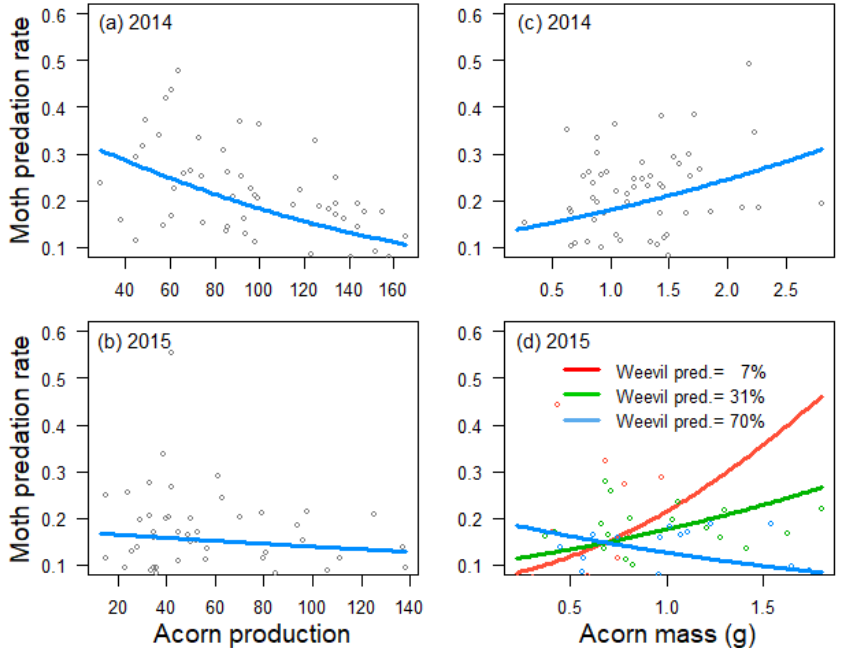
Figure 2. Relationship between tree crop size and moth predation rate in 2014 ( a ) and 2015 ( b ), between acorn mass and moth predation rate in 2014 ( c ) and a cross-sectional plot depicting the interaction between tree acorn mass and weevil predation rate and its effect on moth predation rate in 2015 ( d ), as estimated by generalized linear models. Trend lines fitted to data from 59 Quercus faginea trees in 2014 and 51 trees in 2015. Lines in the cross-sectional plot are cross-sections at the tenth (red line), fiftieth (green line) and ninetieth (blue line) percentiles of weevil predation rate in 2015.